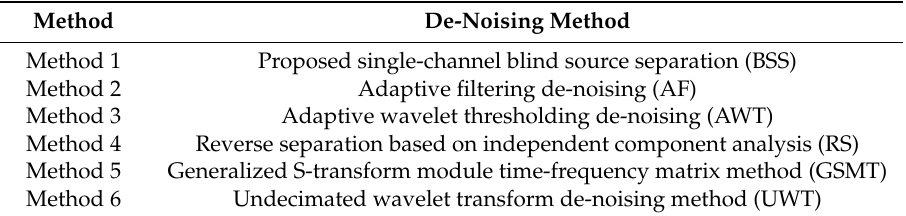
Table 2. De-noising method.